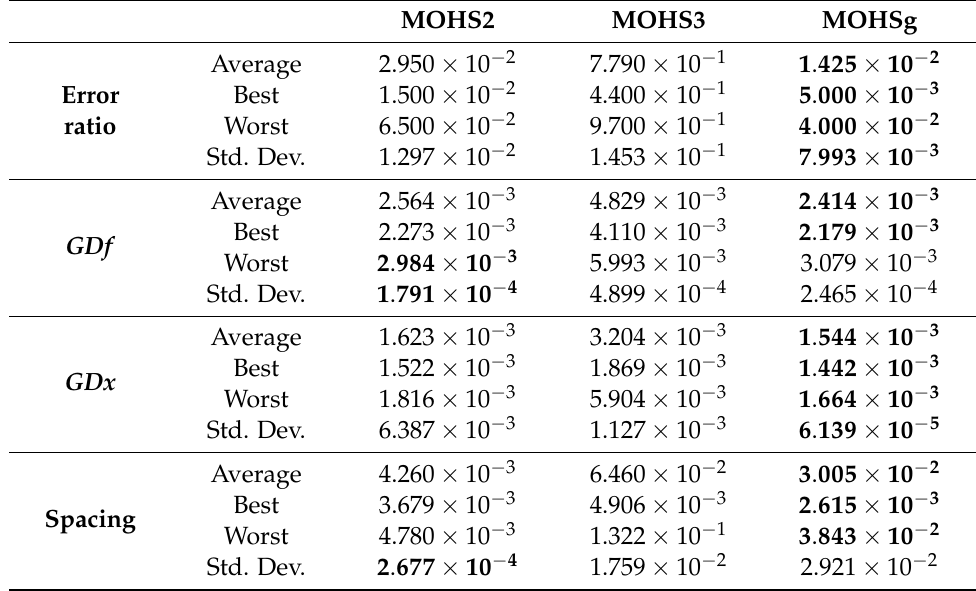
Table 5. Statistic analysis for problem P3.